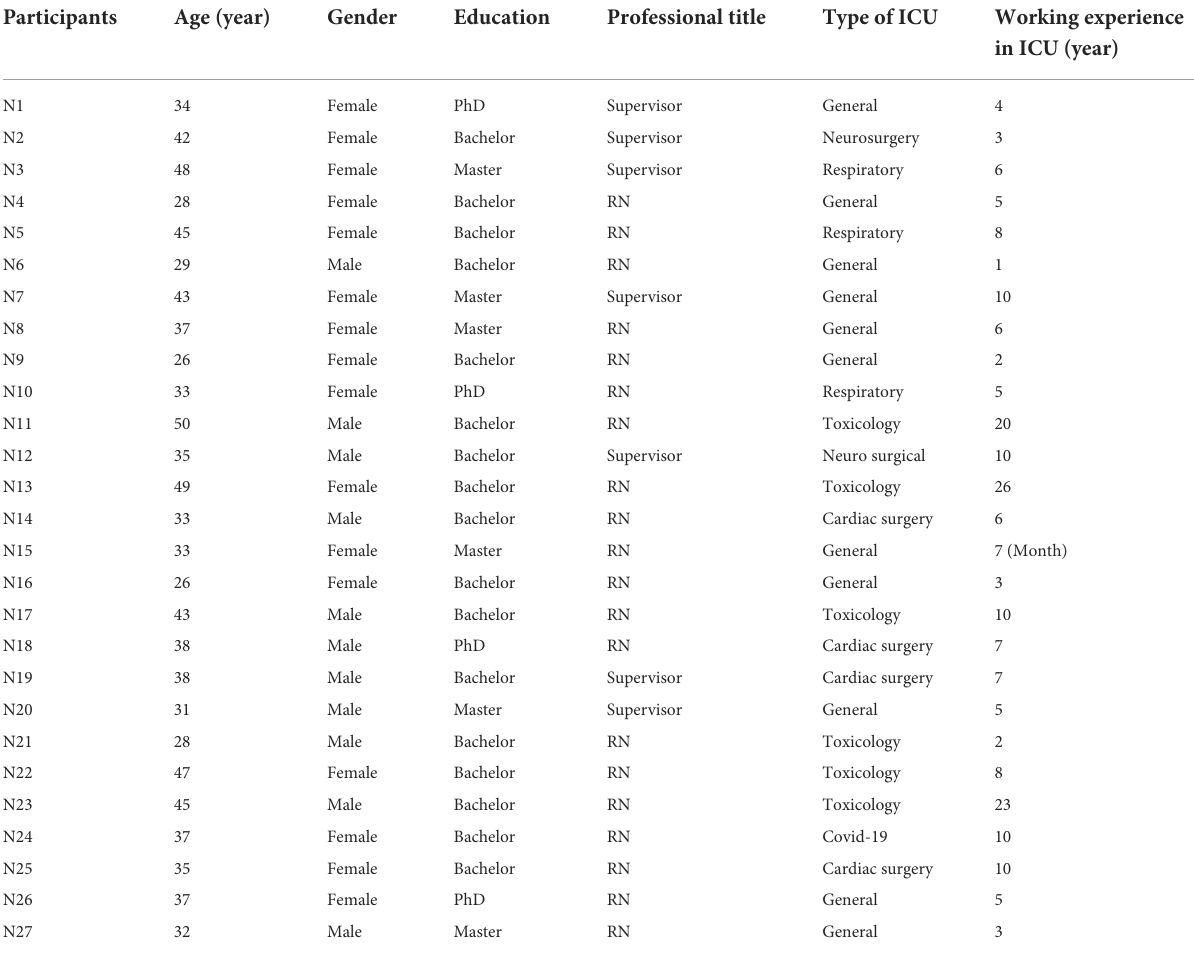
TABLE 2 Characteristics of